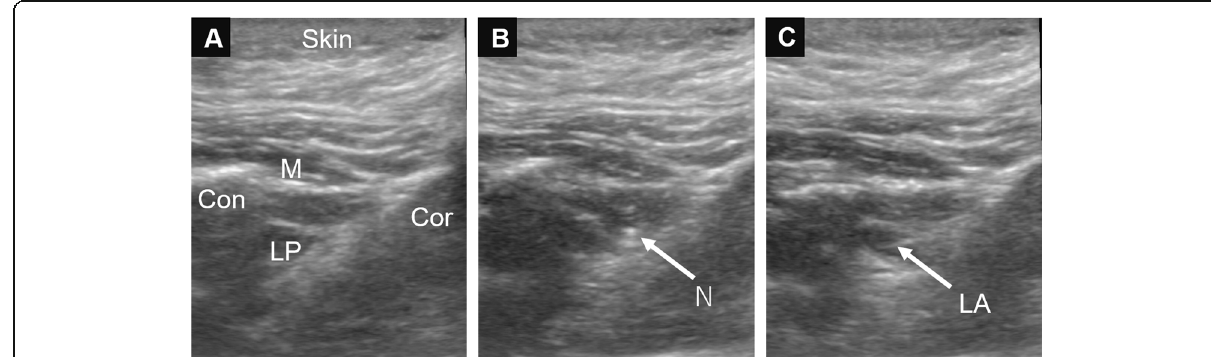
Fig. 1 Ultrasound images and technique of inferior alveolar nerve block. A 22-G block needle was inserted using the lateral extraoral technique to infiltrate the inferior alveolar nerve. a , before needle insertion; Cor, coronoid; Con, condyle; M, masseter; LP, lateral pterygoid muscle; b , needle insertion; N, needle; c , after infiltration of local anesthesia; LA, local